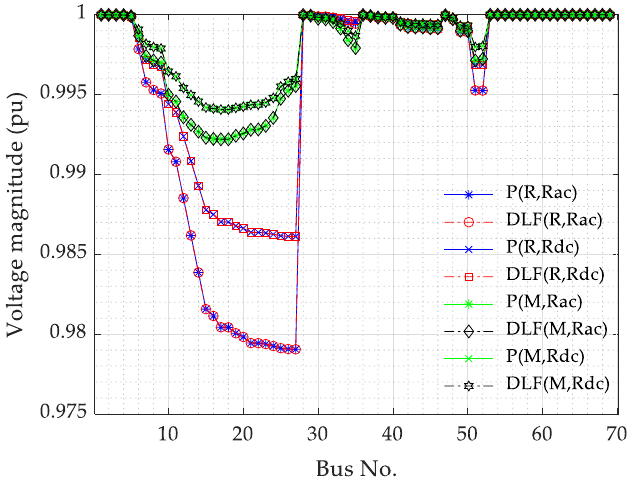
Figure 9. Voltage profile of the 69-node test feeder at a nominal load (P = proposed, M = meshed).